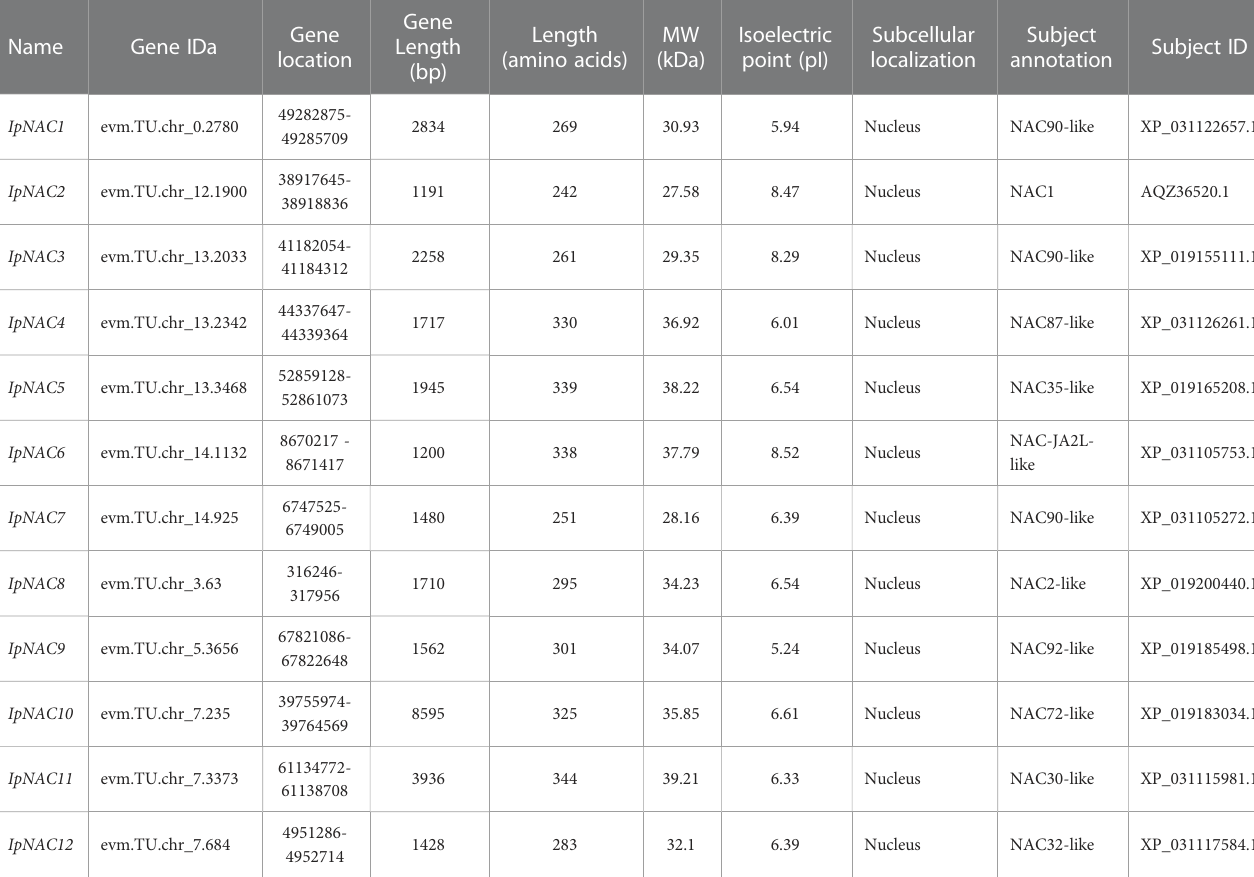
TABLE 1 The information of screened salt stress-responsive Ipomoea pes-caprae IpNAC genes in this study.